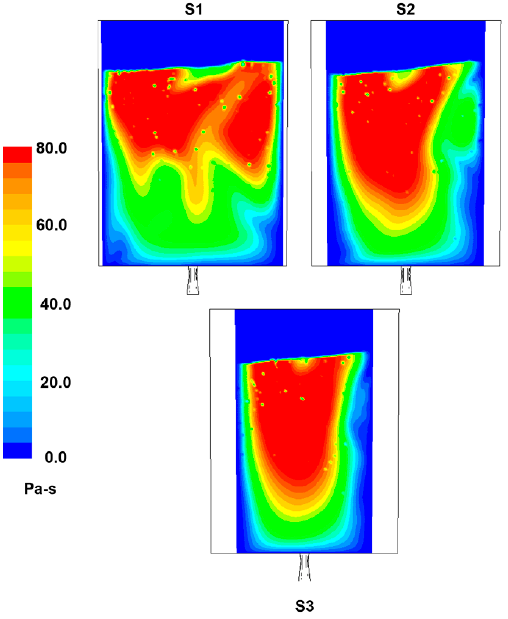
Figure 12. Fields of Turbulent viscosity (Pa-s) in planes of the South sector at a bath level of 80 tons.